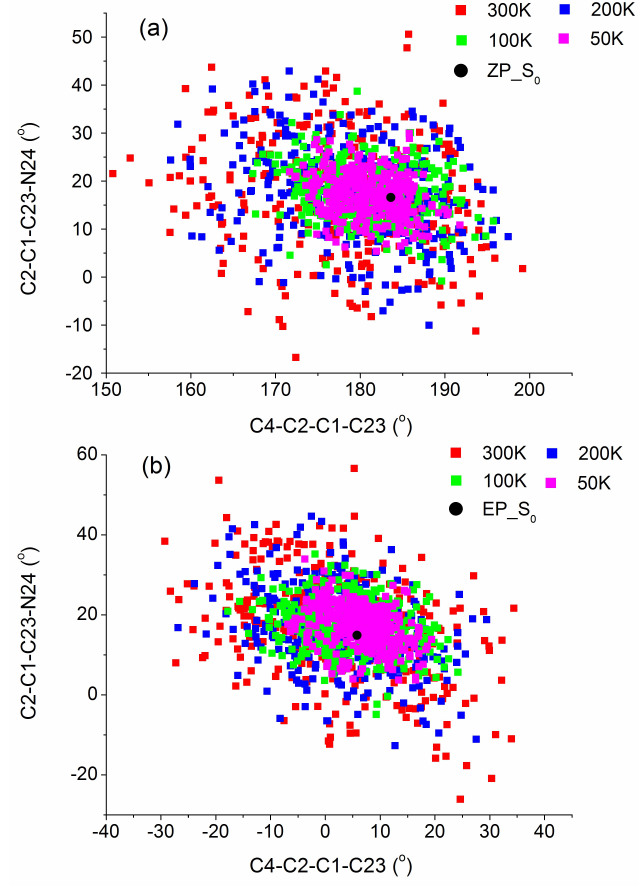
Figure 2. The distribution of C4-C2-C1-C23 and C2-C1-C23-N24 dihedral angles of all sampled initial geometries in Franck–Condon region for ( a ) ZP → EP photoisomerization and ( b ) EP → ZP photoisomerization at 300 K, 200 K, 100 K and 50 K. The corresponding points of ground state ZP and EP isomers are also presented in this